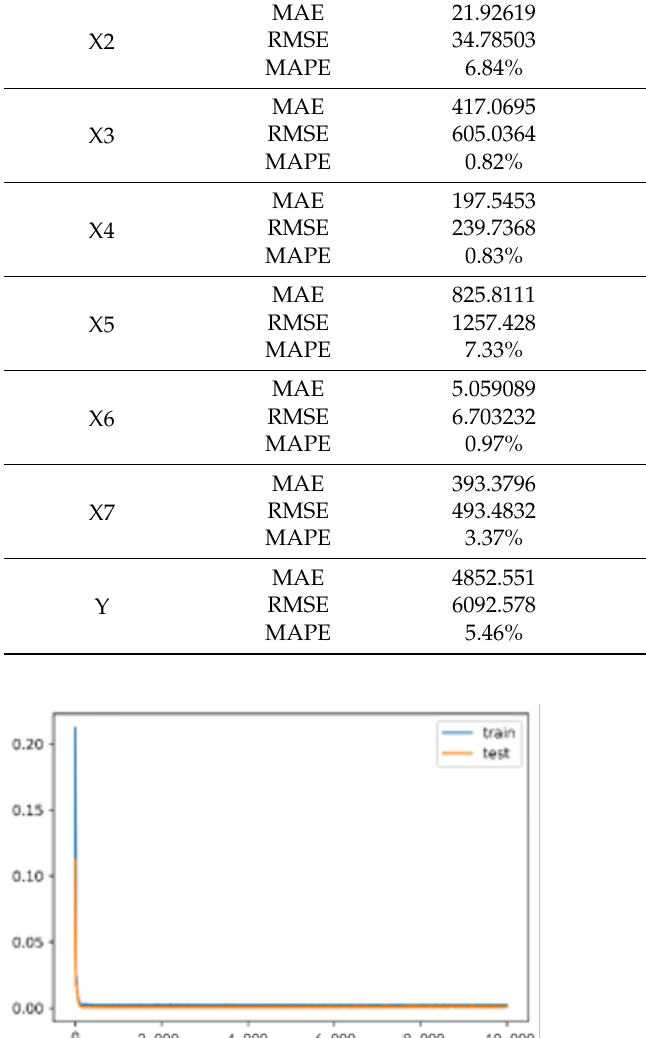
Figure 9. The auto-regressive training result of LSTM. Using LSTM, combined with the predicted values of each factor (see Table 6), this paper predicts the manufacturing demand of GD from 2020 to 2022. In Table 7 and Figure 10, the predicted results were 14,708.04 billion yuan, 14,878.35 billion yuan, and 1497.72 billion yuan , respectively. According to the forecast data, from 2004 to 2022, the demand of GD’s manufacturing industry will increase from 2955.492 billion to 14977.24 billion yuan, with an average annual growth of 8.92%. Table 6. Factor forecast for the next three years.